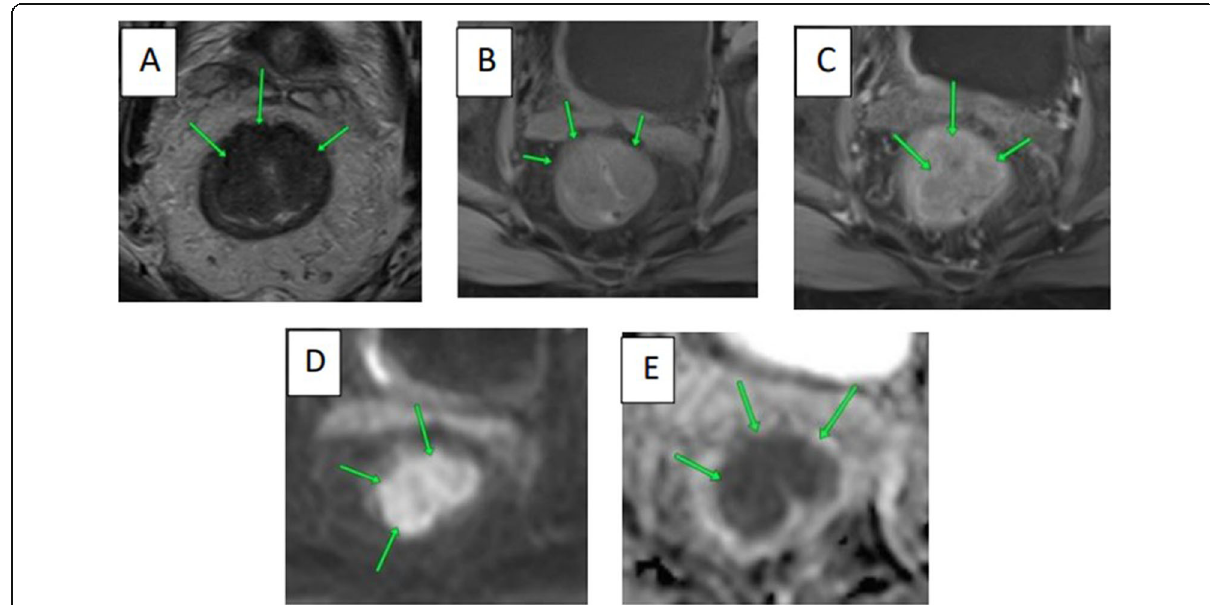
Fig. 2 Sixty-three-year-old male presented with bleeding per rectum. Colonoscopy and biopsy revealed rectal moderately differentiated adenocarcinoma. A middle third horseshoe shaped rectal mass (measured 4.2 × 3.4 × 3.6 cm) sparing the posterior wall with no invasion to the mesorectal fat was noted. It displayed intermediate signal in both T2- ( A ) and T1 ( B )-weighted images with mild homogenous enhancement in post contrast images ( C ). The lesion appeared bright in DWIs ( D ) and turned dark in the ADC map ( E ), with ADC value 0.95 × 10 − 3 mm 2 /s,